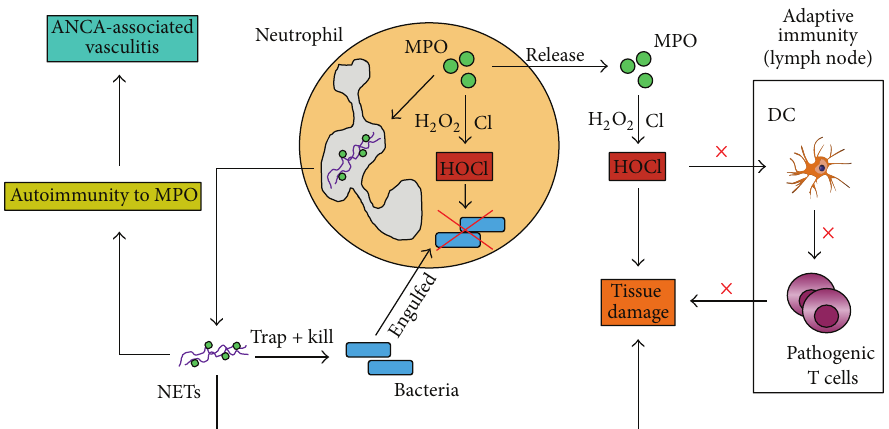
Figure 3: Summary of MPO involvement in neutrophil functions in innate and adaptive immunity . MPO is involved in microbe clearance by neutrophils both intracellularly (via the production of HOCl) and extracellularly (via the release of NETs). On the other hand, the release of MPO-containing NETs can result in the generation of autoimmunity against MPO and subsequent development of ANCA- associated vasculitis. HOCl that is produced outside of activated neutrophils following MPO release can cause significant tissue damage. In contrast, MPO that is released by neutrophils in lymph nodes can inhibit DC activation and thus generation of adaptive T cell responses, thus attenuating organ injury. HOCl, hypochlorous acid; H 2 O 2 , hydrogen peroxide; Cl, chloride; NETs, neutrophil extracellular traps; DC, dendritic cell; ANCA, anti-neutrophil cytoplasmic